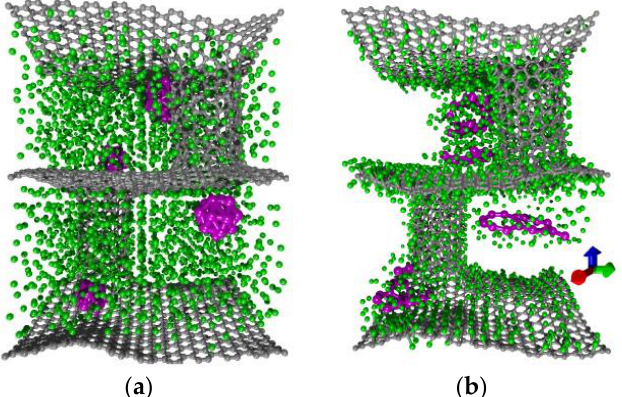
Figure 2. Lithiation of anode material on the example of model I with five Si16 clusters: ( a ) initial configuration; ( b ) result of numerical simulation.